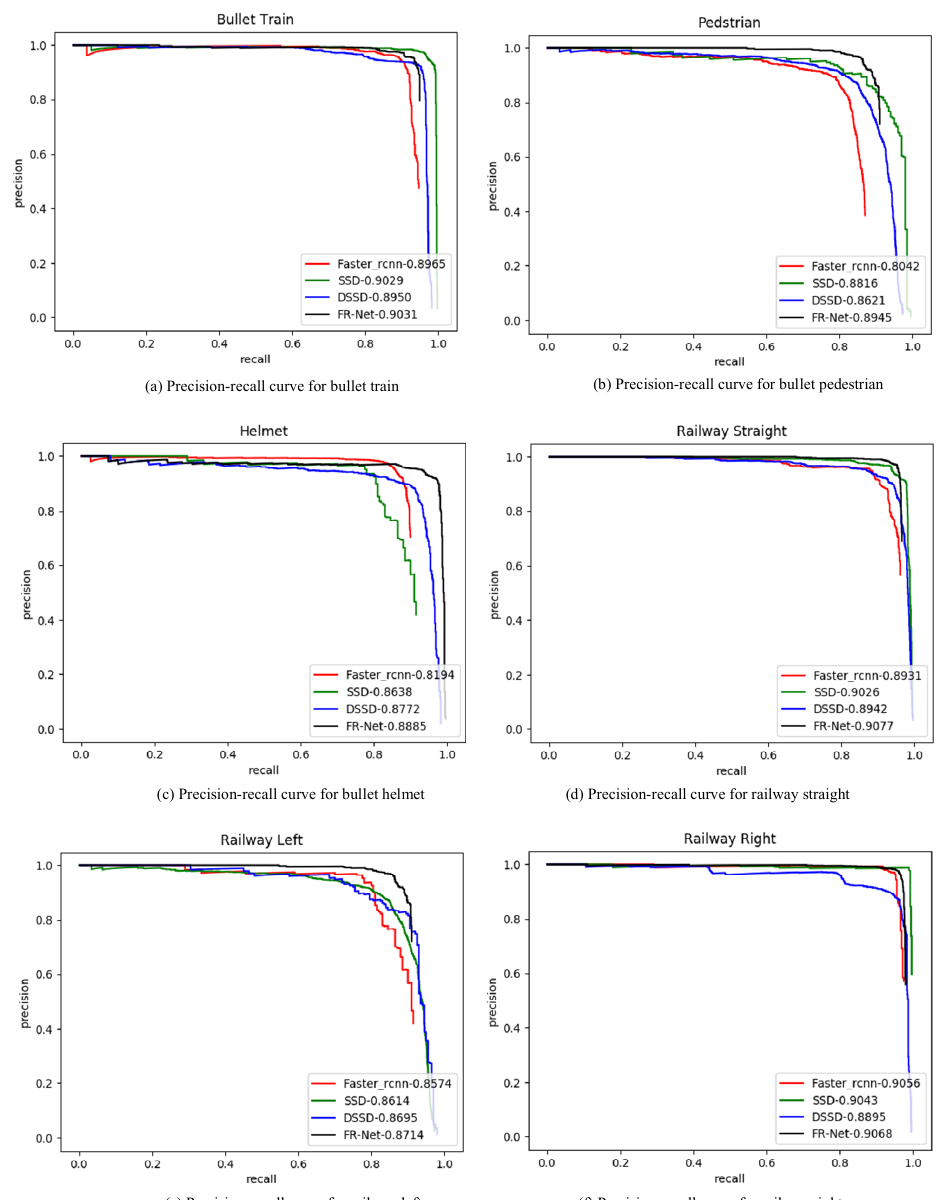
Figure 6. Precision-recall curves for different optimization algorithms with respect to different objects. The red line represents the result of Faster rcnn. The green line reflects the result of the single-shot detector (SSD) method. The blue line shows the result of the deconvolutional single-shot detector (DSSD). FR-Net is the black line.